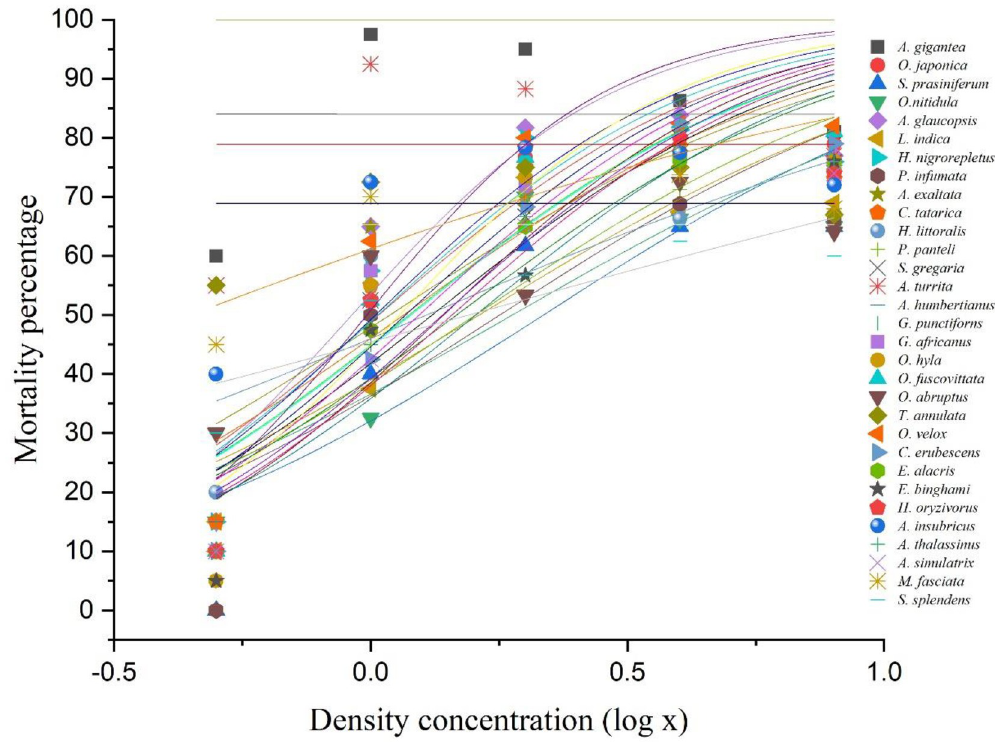
Fig 3. Dose-response log-logistic regression model curves for 31 acridid species. In this plot, the X-axis (independent variable) is referred to as ‘dose’ (species density in log scale = density concentration), and the Y-axis (dependent variable) is referred to as ‘response’ (mortality percentage of the species). Density concentrations (0.5, 1.0, 2.0, 4.0, and 8.0) for DL1 (10/ 20), DL2 (10/10), DL3 (10/5), DL4 (10/2.5) and DL5 (10/1.25) are thus plotted in log scale on the X-axis. The regression curves are developed based on species mortality at five density concentrations. The presented 31 dots for a single density concentration represent the 31 grasshopper species. The non-sigmoid mortality curves indicate that such species do not follow the rest pattern due to idiosyncratic (alike) mortalities across the